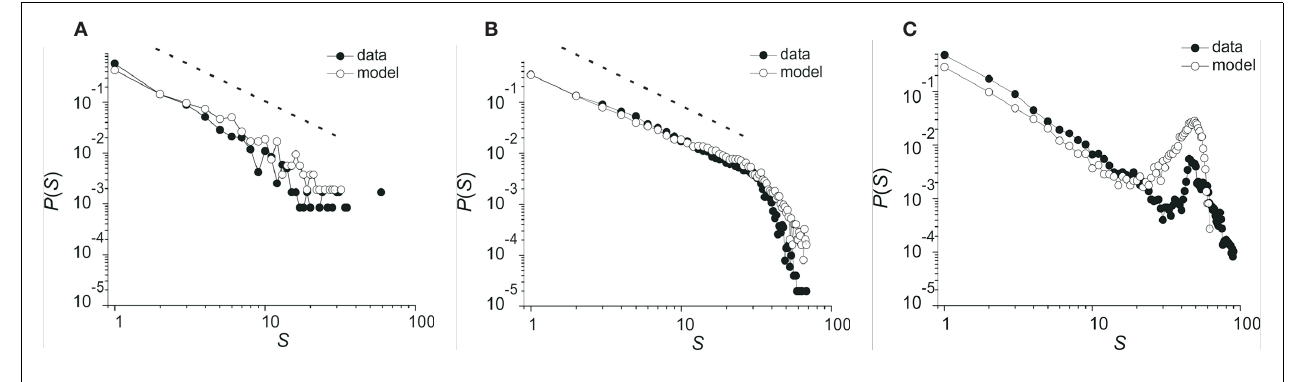
CNQX) applied. (B) Critical regime; normal network. (C) Supercritical regime; inhibitory antagonist (2mM PTX) applied (Haldeman and Beggs,